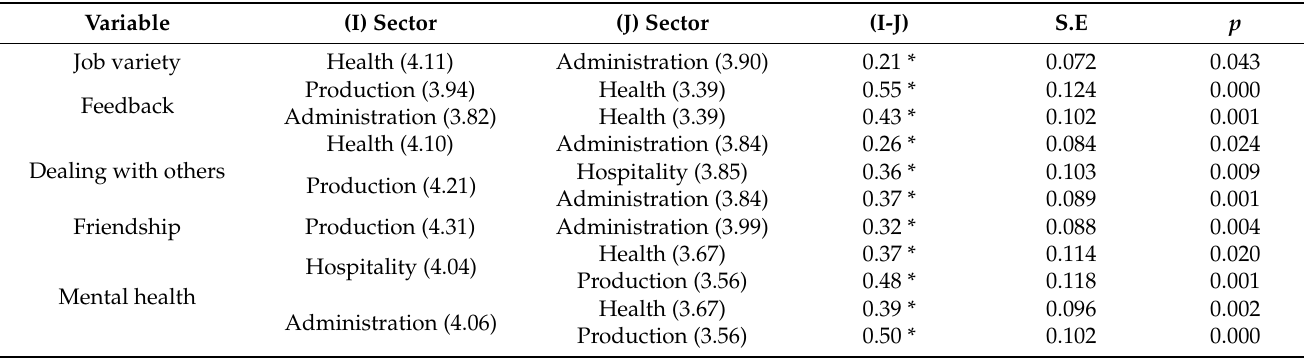
Table 7. Post hoc tests—significant differences between the organizations of different